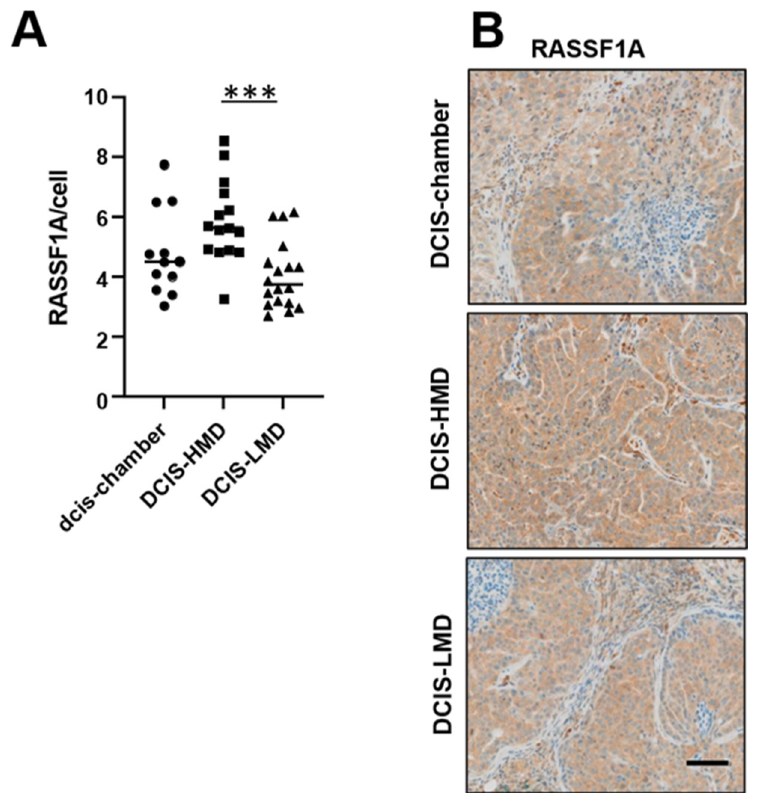
Figure 3. High MD in murine biochambers promotes RASSF1A expression in DCIS-like lesions formed by DICS.com cells. ( A ). Quantitation of RASSF1A intensity per cell; DCIS-chamber n = 4, DCIS-HMD n = 6, and DCIS-LMD n = 6 patient-derived paired (high versus low) biochambers were examined, with 3 40× magnification fields quantified per patient. *** denotes p < 0.001. ( B ). repre- sentative images of murine biochamber material, magnification 10×, scale bar = 50 μ m. High versus low MD was determined radiologically from the slice mammogram of patient tissue and thus these are relative terms rather than correlative with in vitro data shown in Figure 1.